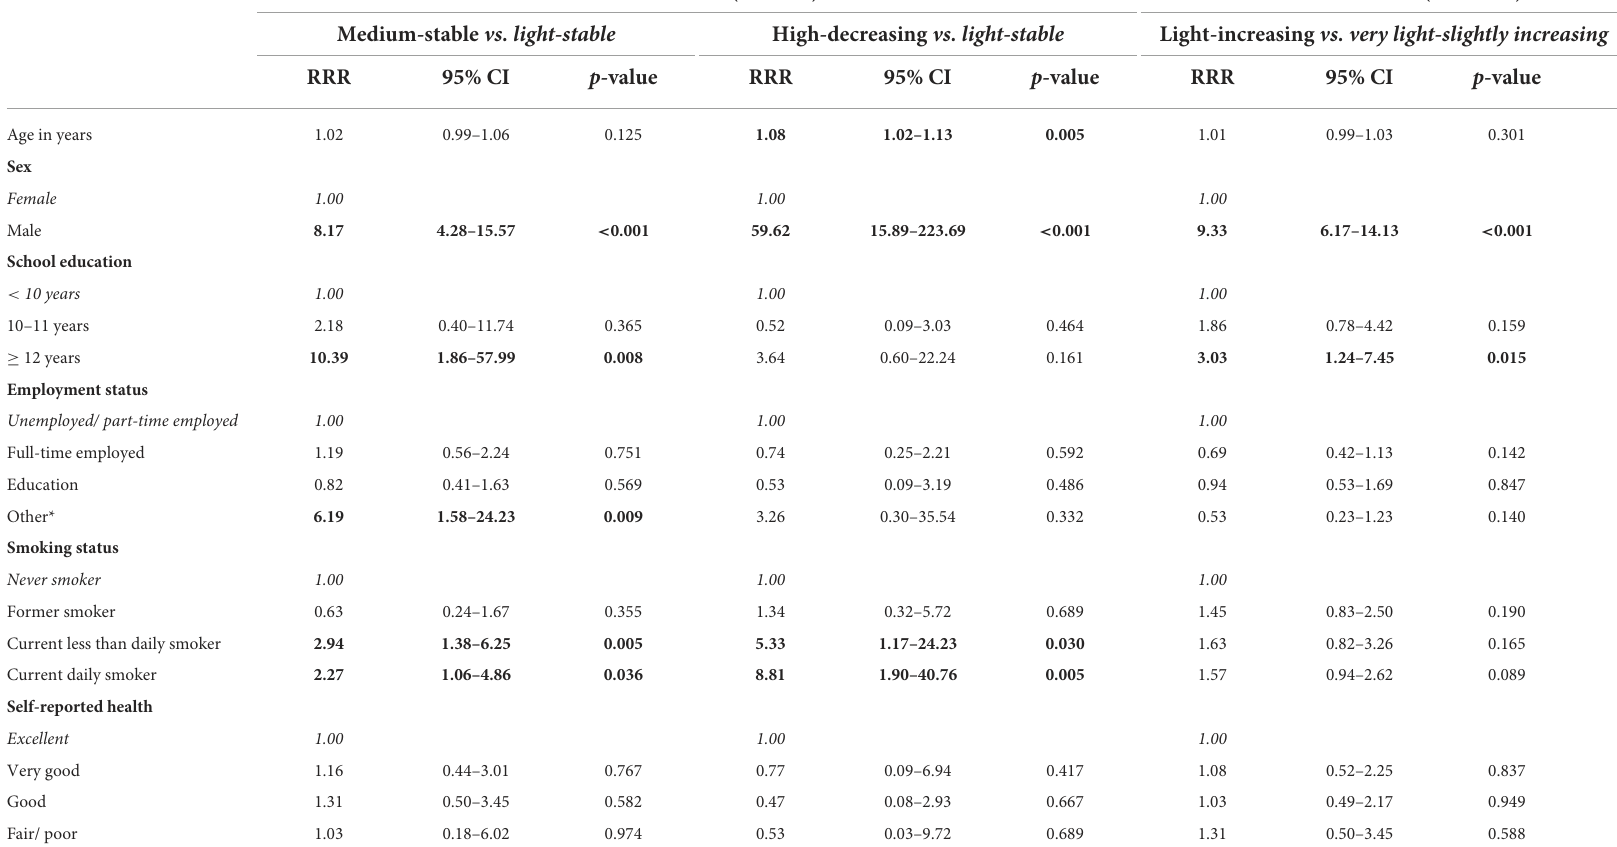
TABLE 4 Results from multinomial logistic regressions to predict latent trajectory class membership for at-risk drinkers and for low-risk drinkers. At-risk drinkers ( n = 553) Low-risk drinkers ( n = 1085) Medium-stable vs. light-stable High-decreasing vs. light-stable Light-increasing vs. very light-slightly